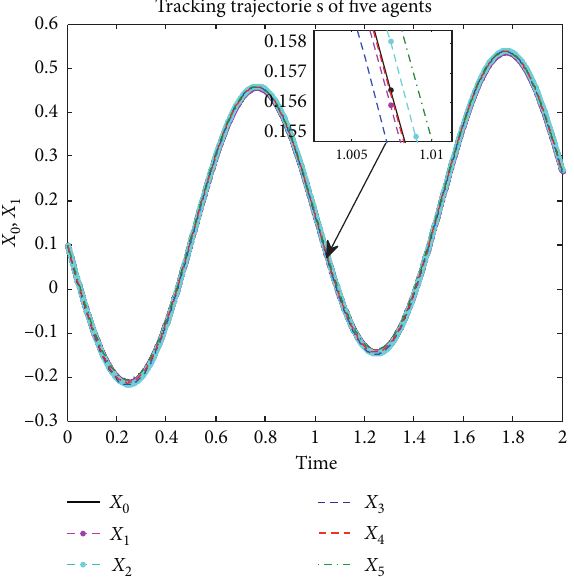
Tracking trajectorie s of five agents 0.6